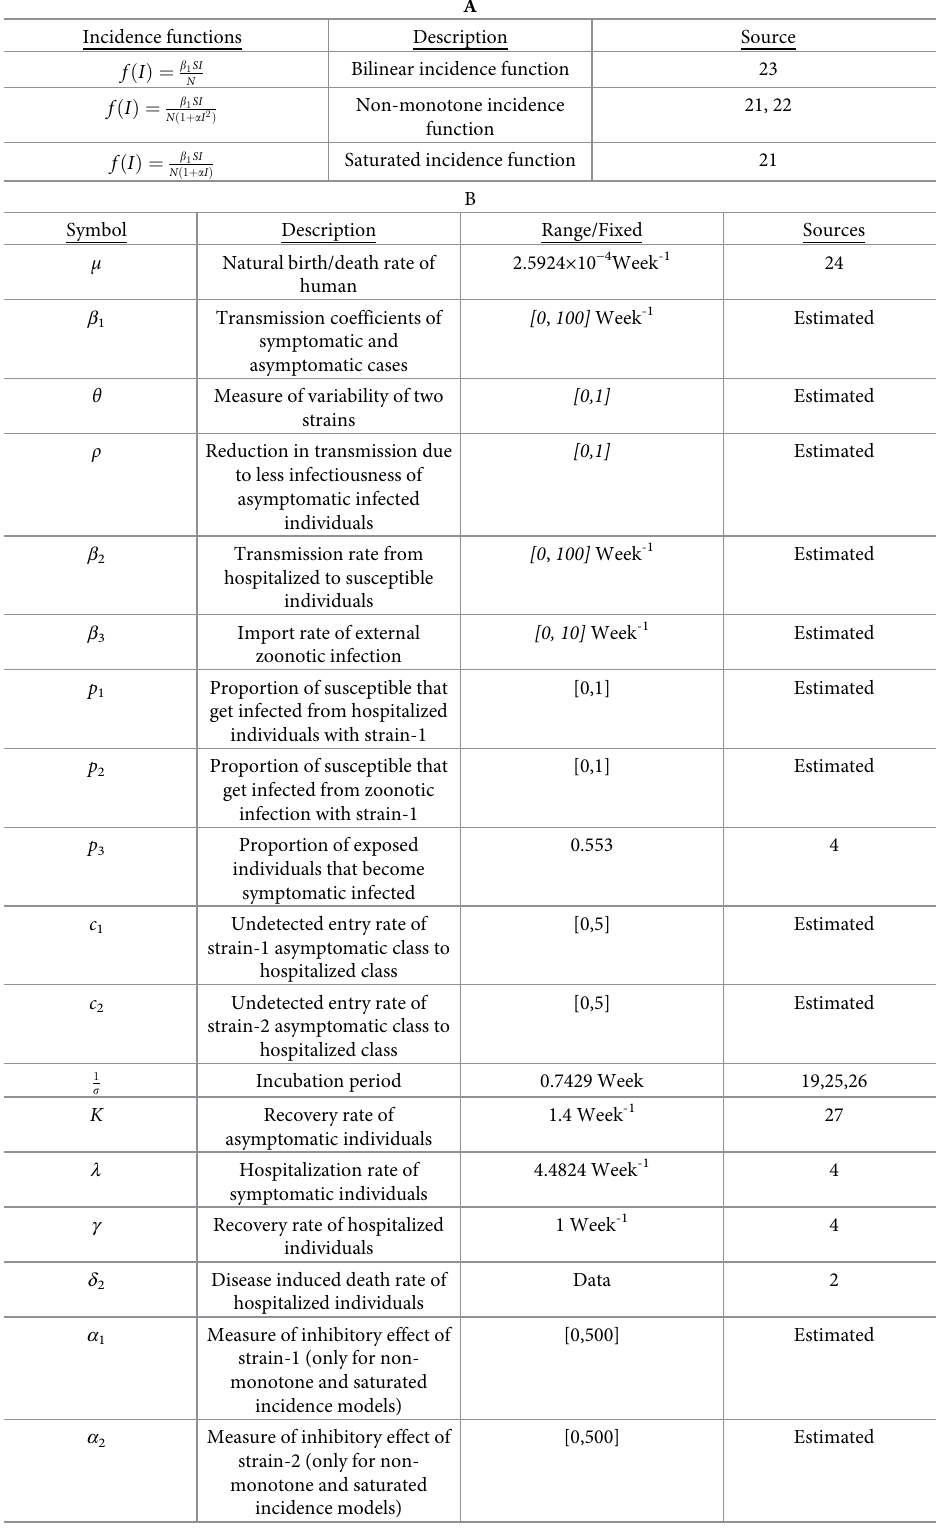
Table 1. (A)Description of the incidence functions for the three models considered. (B)Main parameters of the three 2-strain